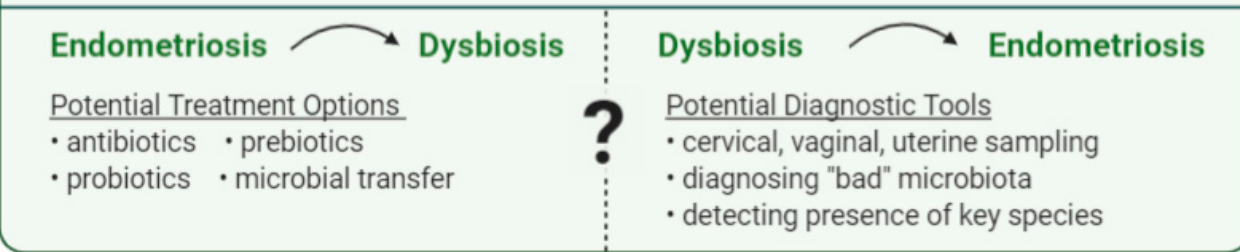
Figure 6. Summary of current limitations, future directions and possible outcomes.